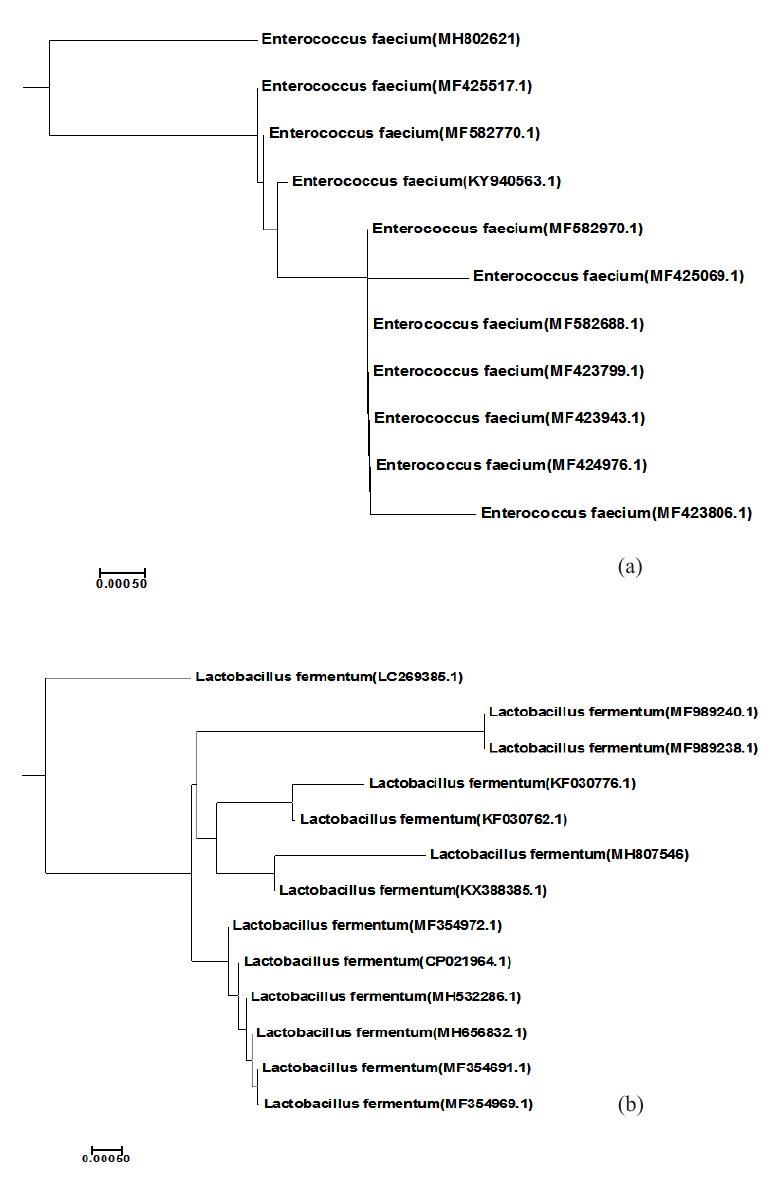
Fig. 3. Phylogenetic tree of both LAB strains CK21(a) and